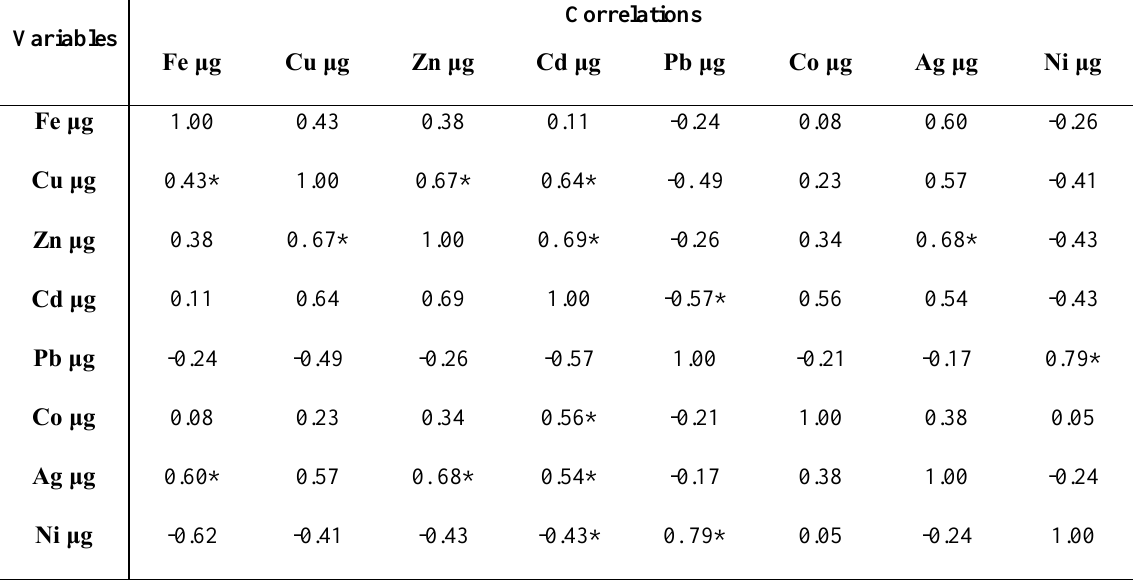
Table 5. Coefficients of heavy metals correlation of water from Lake Reghaia